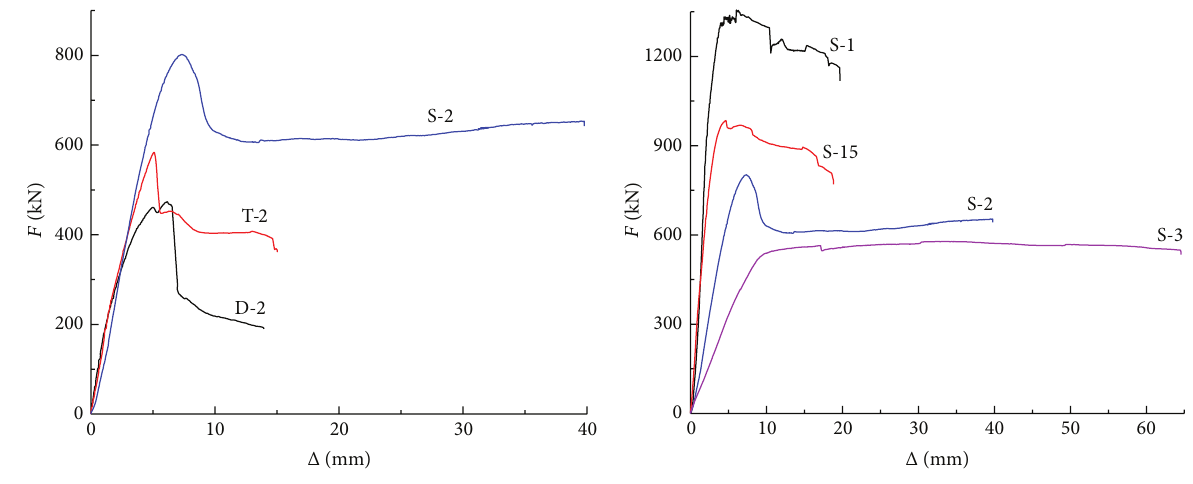
Figure 4: Load-deflection curves of all